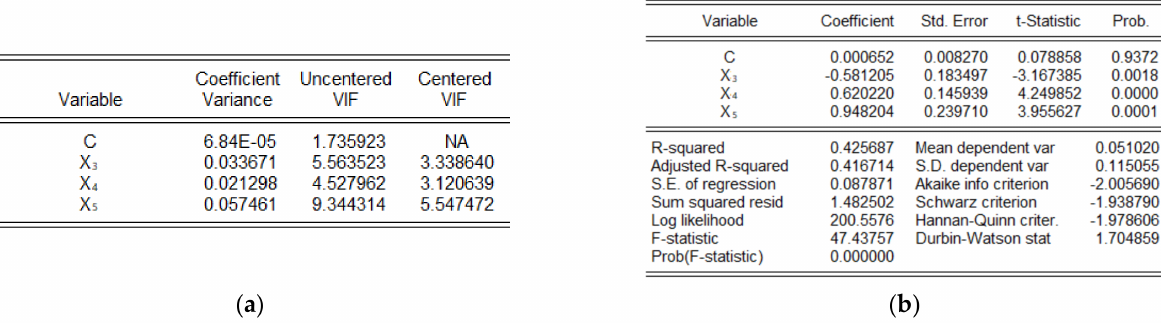
Figure 6. Predictive model (5) second test results. ( a ) VIF test results of Model 6.; ( b ) model (5) second test